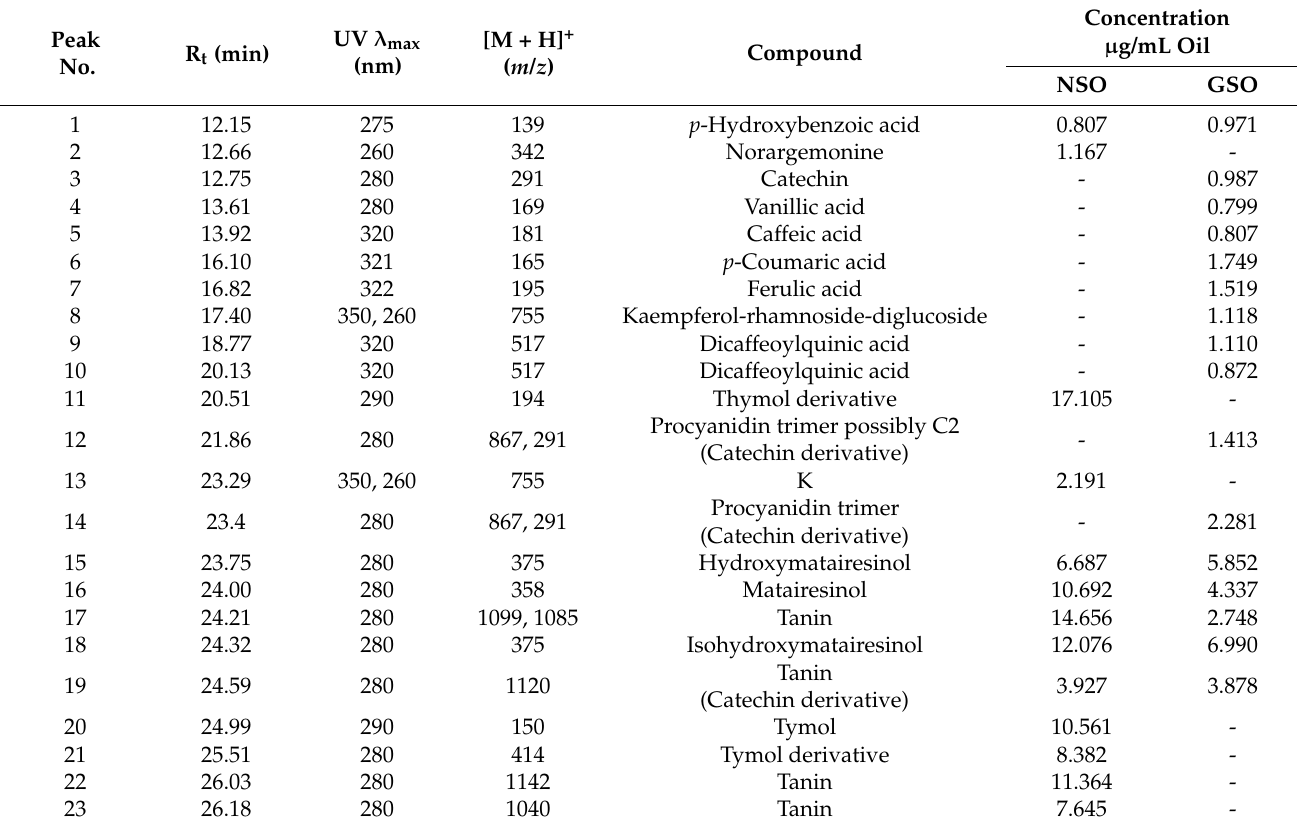
Table 4. Tentative identification, characterization, and concentration of major compounds identified in NSO and GSO extracts. Peak